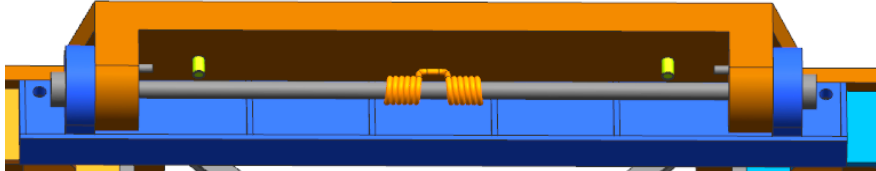
Figure 5. OLMDC model.